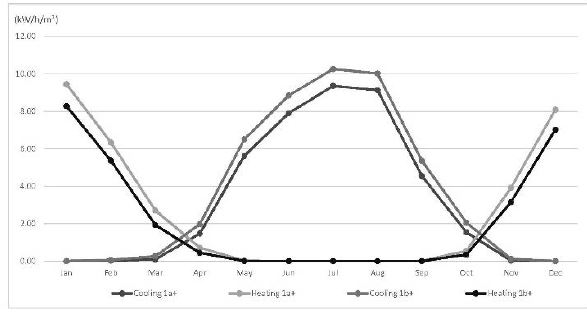
Fig. 3. Monthly energy consumption for heating and cooling in newly proposed designs, 1a+,1b+